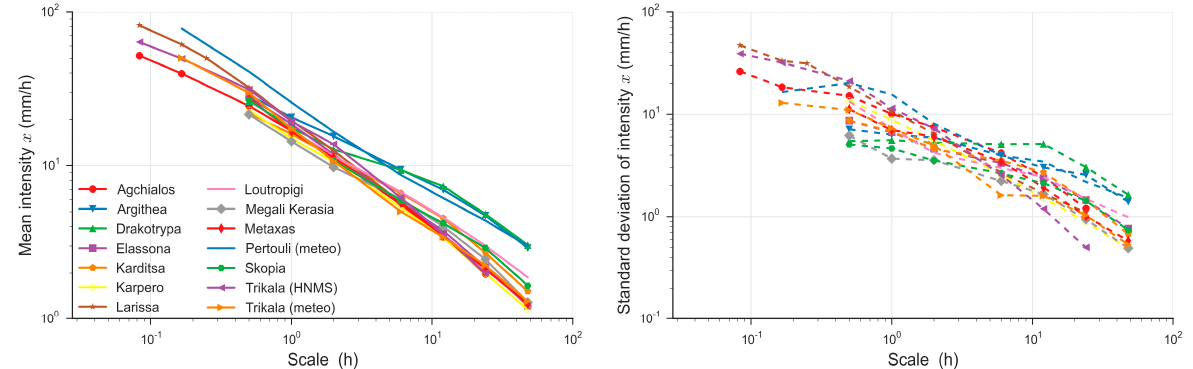
Figure 2. Mean and standard deviation of the empirical rainfall intensities for 5 min to 48 h scales for the 14 fine-scale rainfall stations.